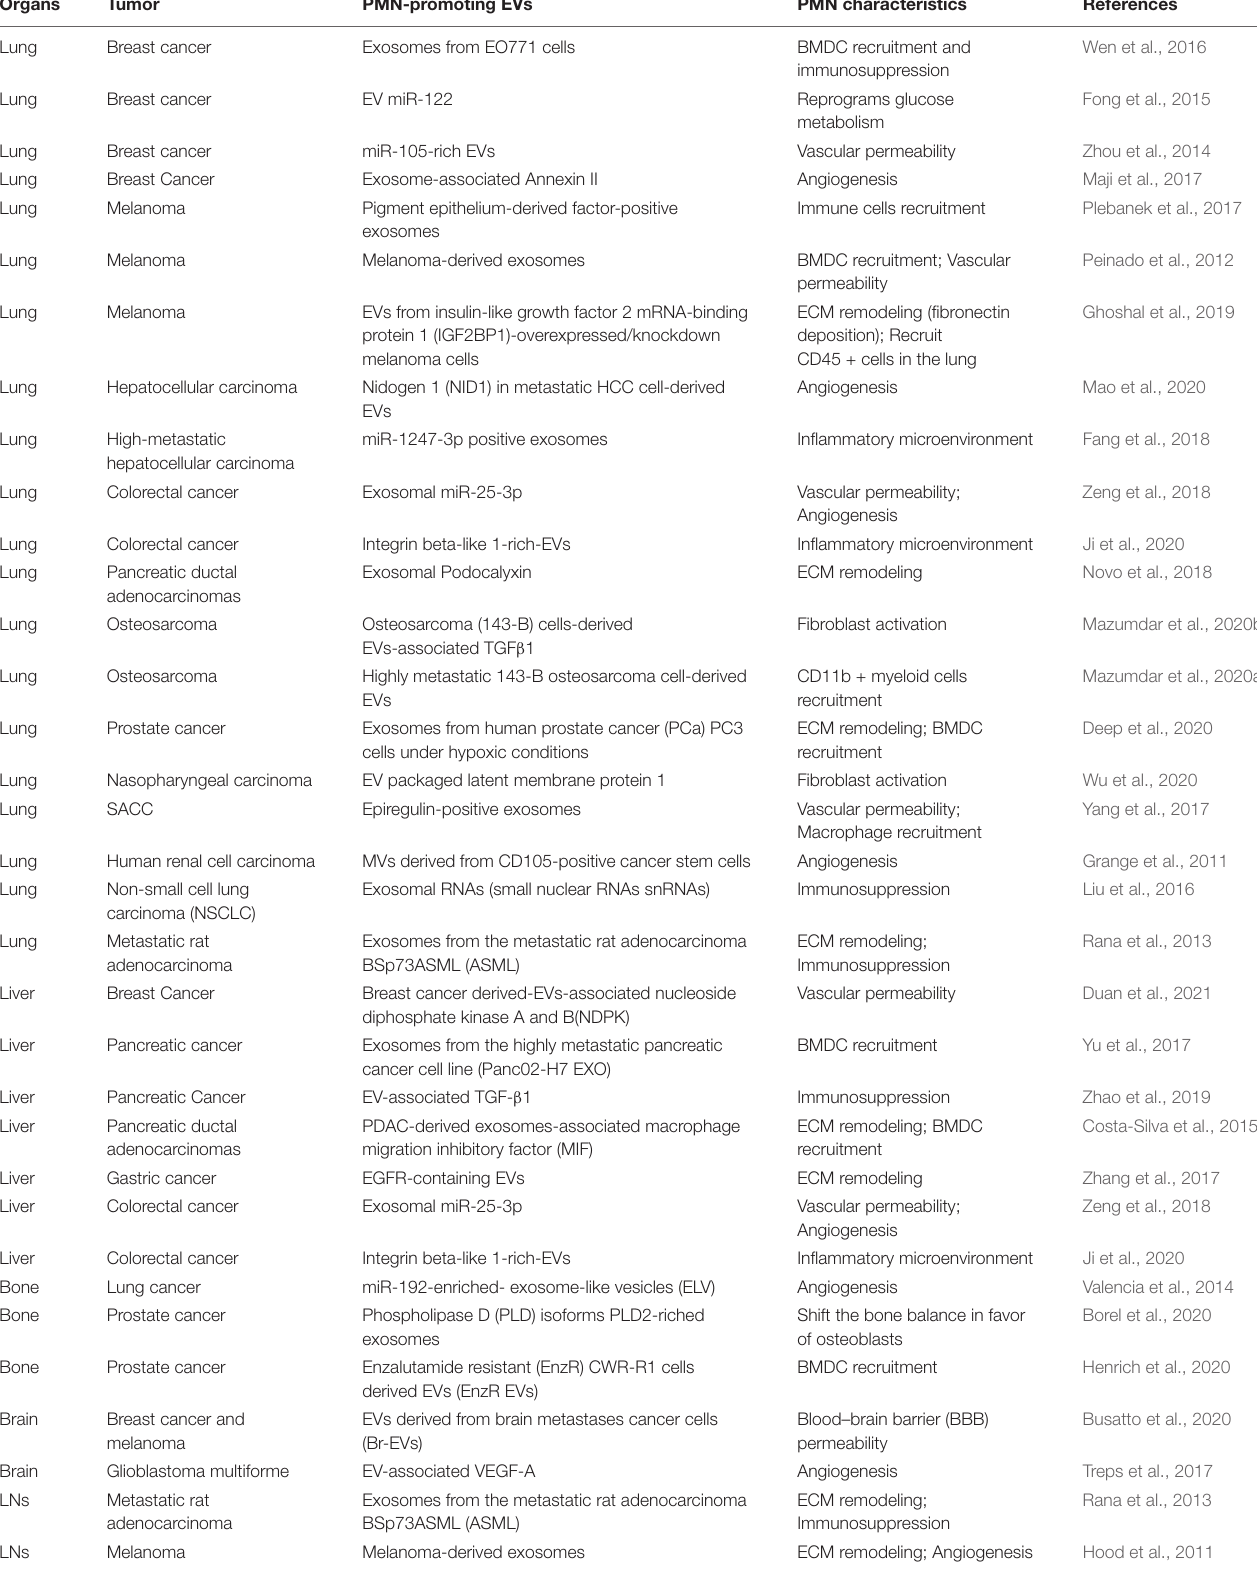
TABLE 1 | Pre-metastatic niche (PMN) formation promoted by extracellular vesicles (EVs).